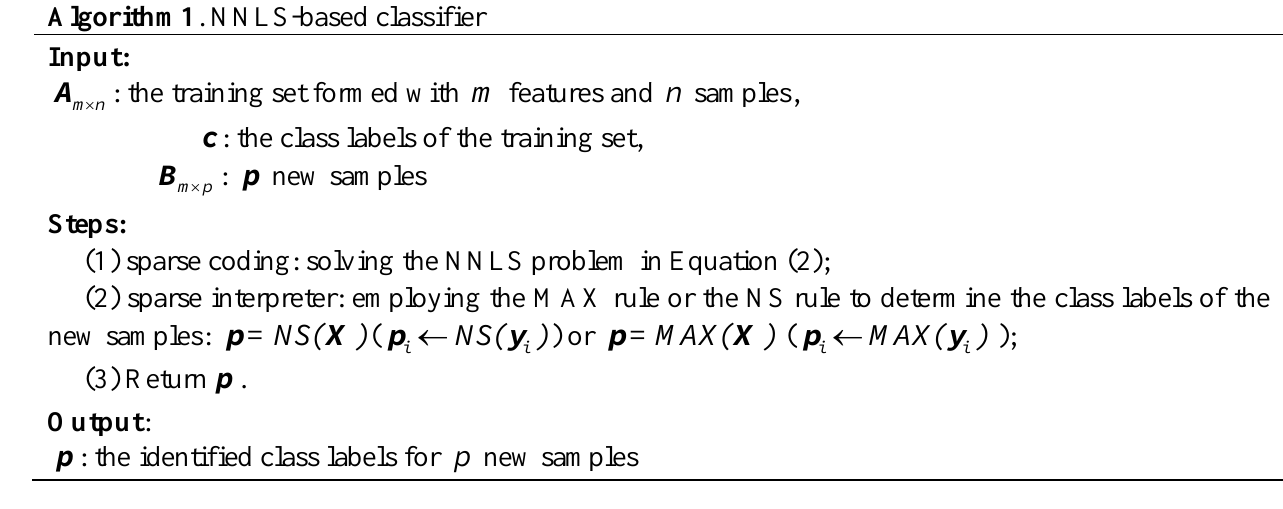
Algorithm1 . NNLS-based